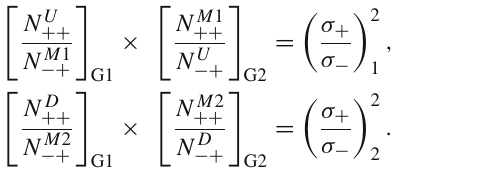
Fig. 3 Kinematic distributions of selected SIDIS events vs. Q 2 and y and of charged hadrons vs. z and p h 2006 (lower, red), 2002 – 2004 (middle, green) and 2002–2006 (upper,